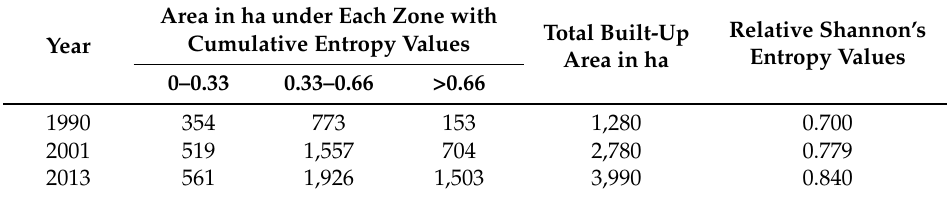
Table 9. Temporal changes in areas under urban sprawl in Al-Khobar: 1990 ´ 2013. Area in ha under Each Zone with Cumulative Entropy Values Year